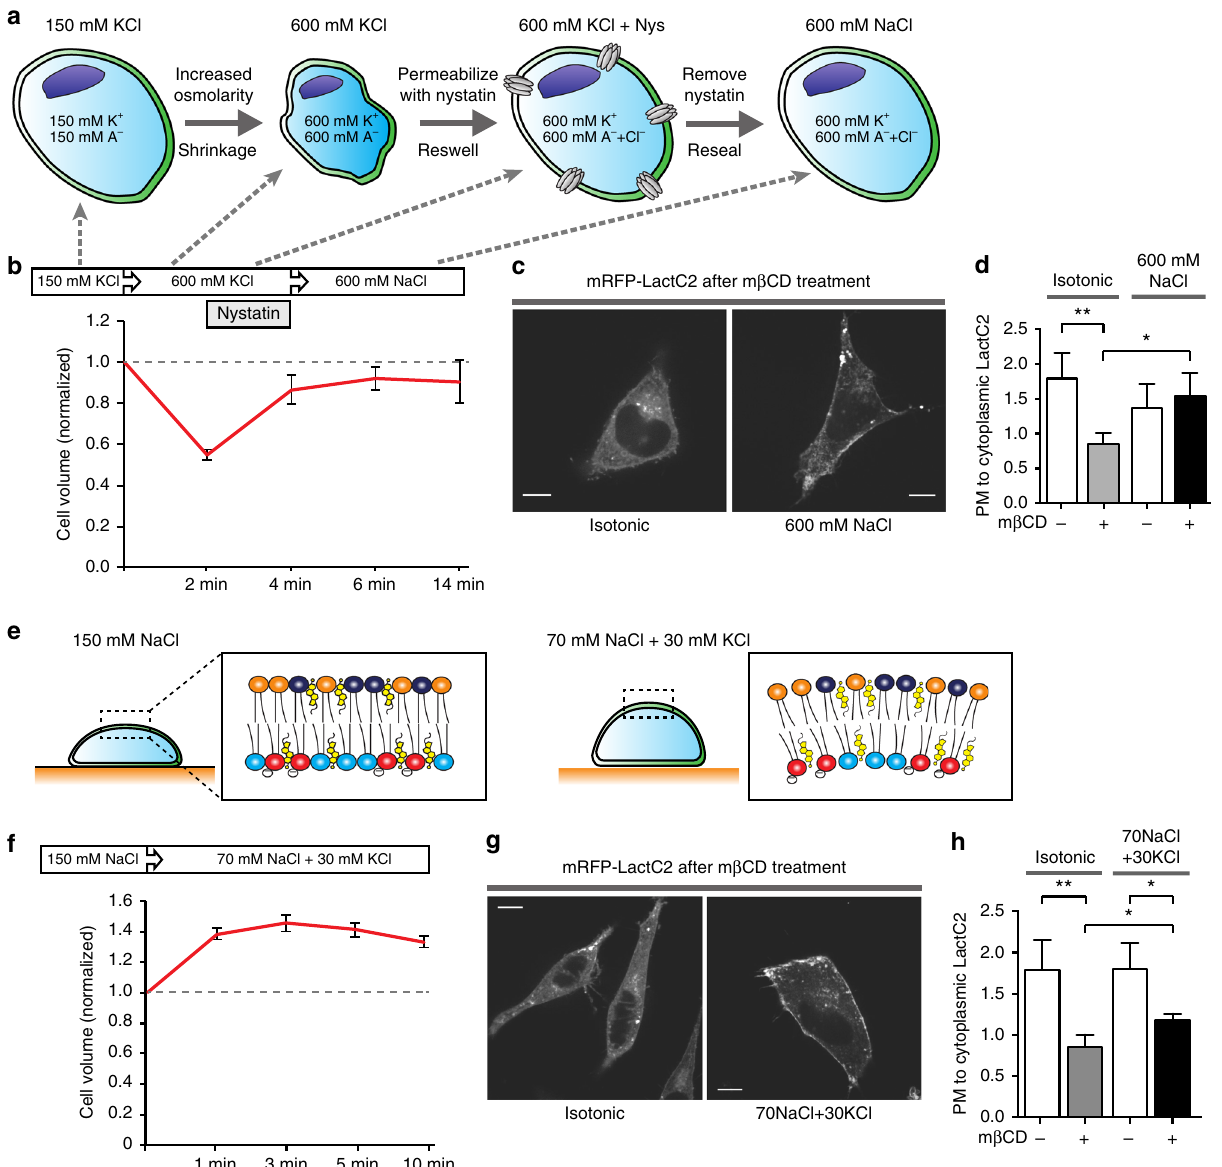
Fig. 5 Increased ionic strength and membrane stretching prevent PtdSer internalization. a Neutralization of surface charge of the inner PM by increasing ionic strength. Increasing osmolarity by incubating in 600 mM KCl led to cell shrinkage. The addition of 40 ng/ µ L nystatin at low temperature allows entry of monovalent ions. To reseal the cells, nystatin is removed by washing with pre-warmed medium. Next cells were incubated in medium containing 600 mM NaCl to prevent further changes in cell size. To measure the cell volume, spinning-disk confocal imaging was performed on HeLa cells expressing mCherry. b The line graph depicts the changes in cell volume under the circumstances described in a . Values represent the means ± s.e.m. n = 4. All the media described in Fig. 5 contained 2 mM CaCl 2 , 1 mM MgCl 2 , 20 mM HEPES, 100 μ M EGTA, 25 mM glucose, pH 7.4. [A − ] represents cellular anions. c HeLa cells expressing mRFP-LactC2 after treatment of 10 mM m β CD in an isotonic medium (left) and in 600 mM NaCl (right). d Quantitation of PM to cytoplasmic fl uorescence ratio of mRFP-LactC2 after treatment of m β CD. e Sustained cell swelling in 70 mM NaCl + 30 mM KCl. Values represent means ± s.e.m. n = 9. f The line graph depicts the change of volume of cells incubated in medium containing 70 mM NaCl + 30 mM KCl. Values represent means ± s.e.m., n = 4. g , h Cells expressing mRFP-LactC2 after treatment of 10 mM m β CD in an isotonic medium (left) and in 70 mM NaCl + 30 mM KCl (right) for 10 min at 37 °C. NS = not signi fi cantly different, *p < 0.05, **p < 0.01 and ***p < 0.005; as determined using a two-tailed t-test. Data are means ± s.e. m., n = from 0.2 to 0.3, while the amount of charged lipids in the outer the expression ¼ 0. monolayer is so small, that its effects can be neglected, ϕ 1 out R B ¼ 2 : 2 nm Assuming that the surface charge density of the inner monolayer ϕ 2 (cid:2) ϕ 2 is the only reason for the bilayer spontaneous curvature, the latter in out would change from about 0.018/nm, which is nearly fl at, to 0.041/ nm, representing a signi fi cant degree of bending. The radius of a (Fig. 4c). As a result of cholesterol extraction, the mole fraction cylinder arising from this spontaneous curvature would decline of charged lipids in the inner monolayer, ϕ , is estimated to rise in